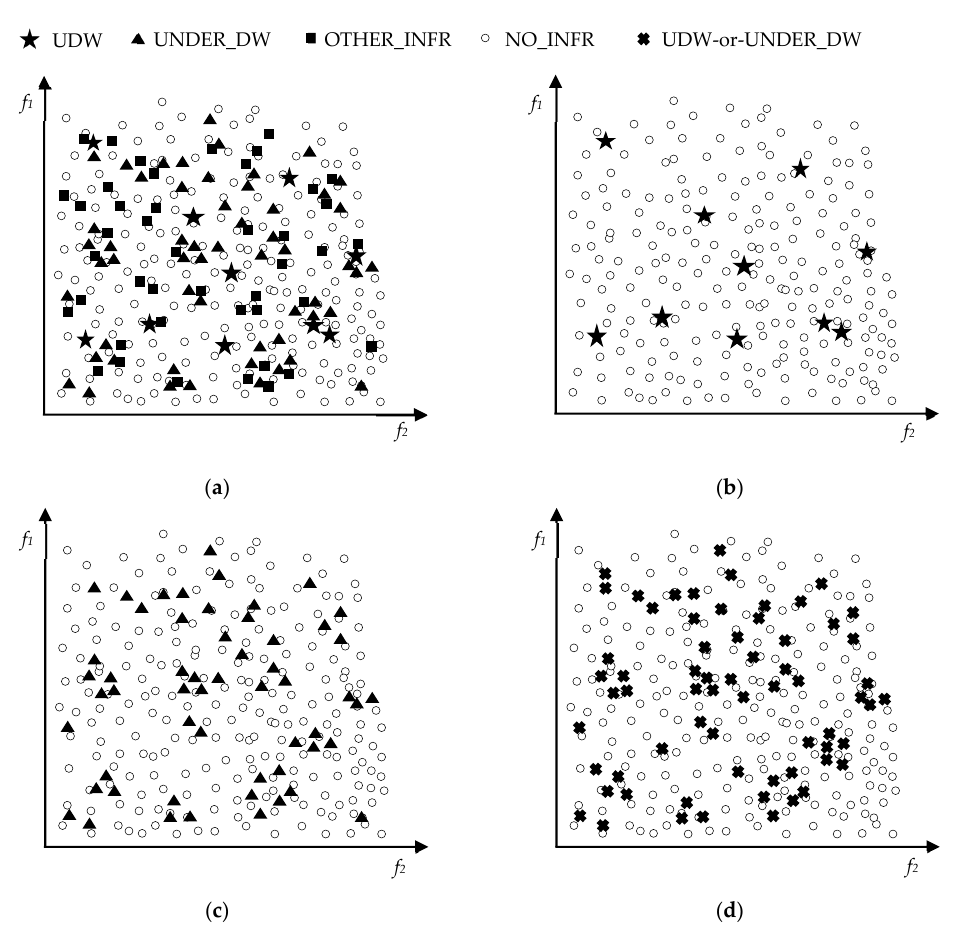
Figure 1. Dataset class distributions in the dataspace: ( a ) initial dataset; ( b ) UDW final dataset; ( c ) UNDER_DW final dataset, and ( d ) UDW-or-UNDER_DW final Table 3. Imbalance and overlap ratios in the final datasets.